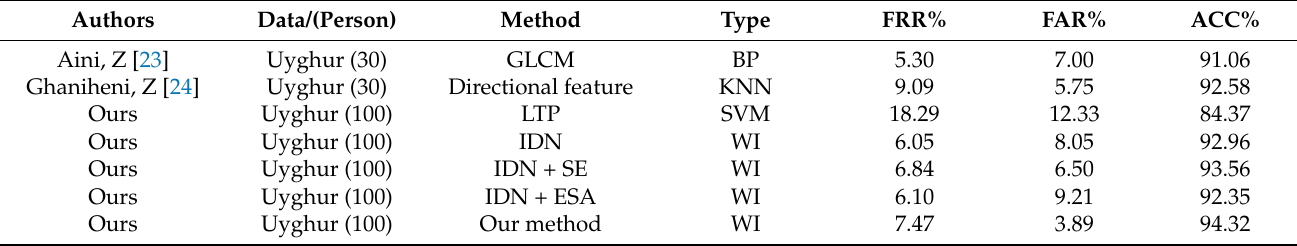
Table 2. Results of Uyghur data sets and comparative